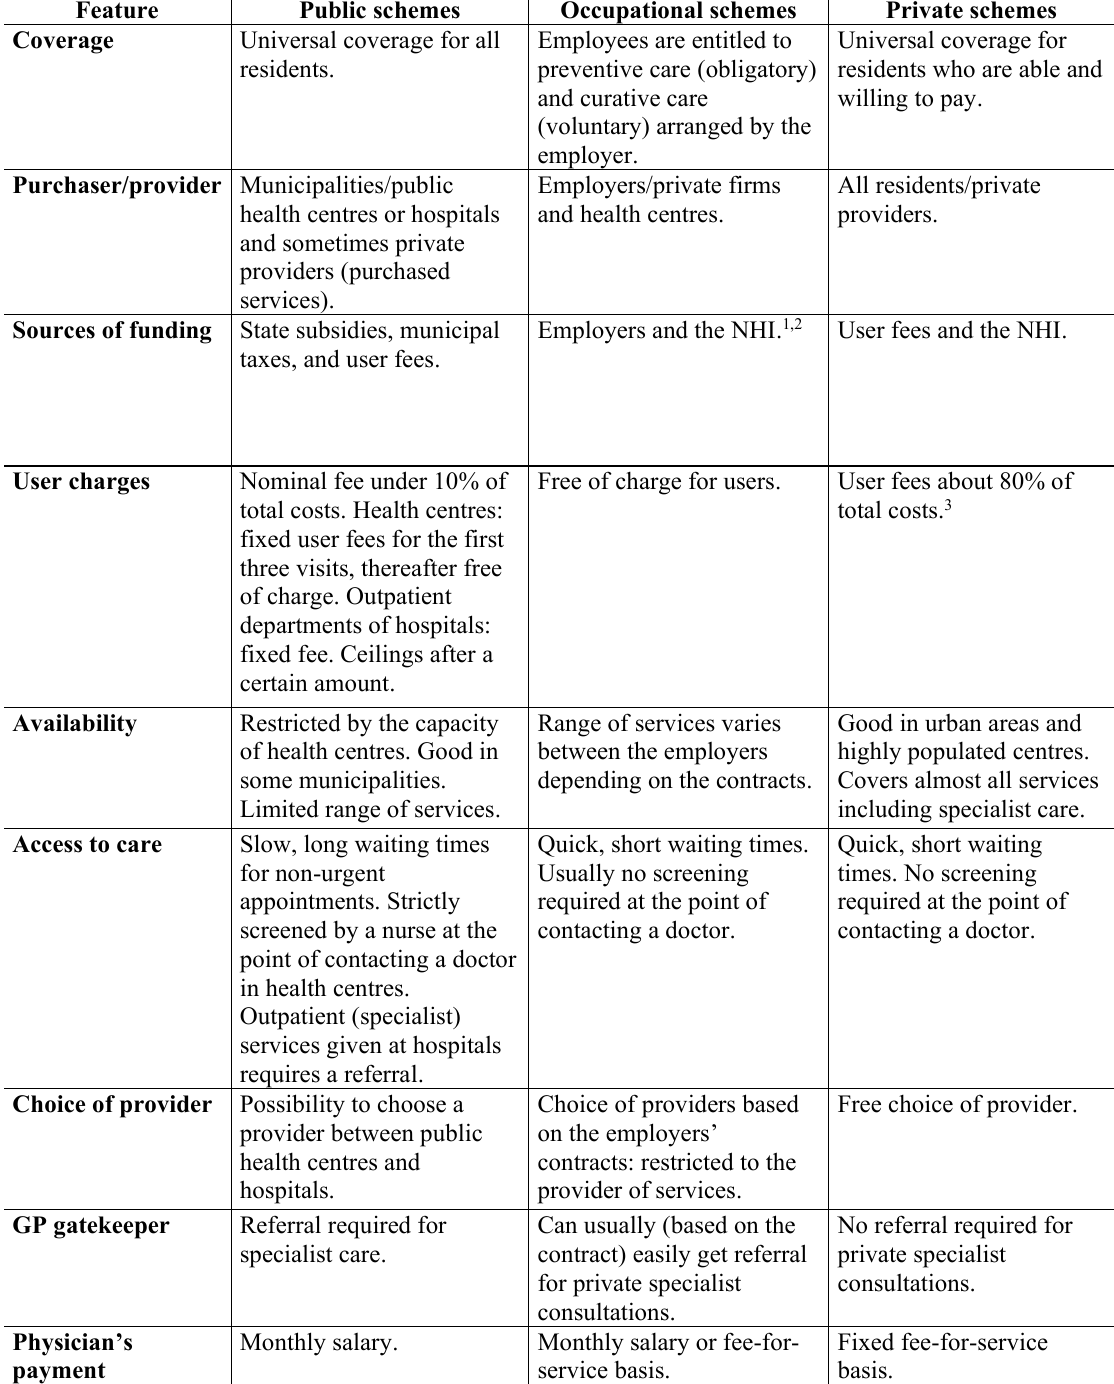
Table 1: Main features of the Finnish tripartite systems in ambulatory care for working age